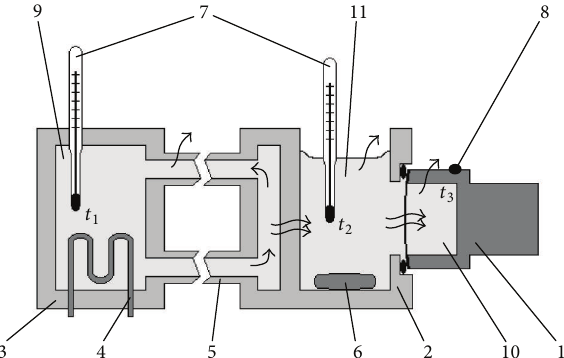
Figure 4: Scheme of warming-up (wavy arrows are heat transfer) of the measuring cell up to the operating temperature: (1) is oxygen sensor (cathode is not shown), (2) is measuring cell, (3) is thermostat, (4) is heating element, (5) is connecting tubes, (6) is magnetic stirrer, (7) is thermometers, (8) is mounting place of ther- mocouples,(9)isheatcarrier,(10)iselectrolyteofoxygensensor,and (11) is incubation medium. 𝑡 1 , 𝑡 2 , and 𝑡 3 are points of temperature control. Warming-up of the system is carried out in the direction of the thermostat-medium-electrolyte. In the state of thermal equi- librium, temperature of the incubation medium (11) is appreciably below the temperature of the heat carrier (9) into the thermostat (3) due to heat losses in the connecting tubes (5). The temperature of the electrolyte (10) is even lower due to the cooling of the oxygen sensor body (1) by ambient air.